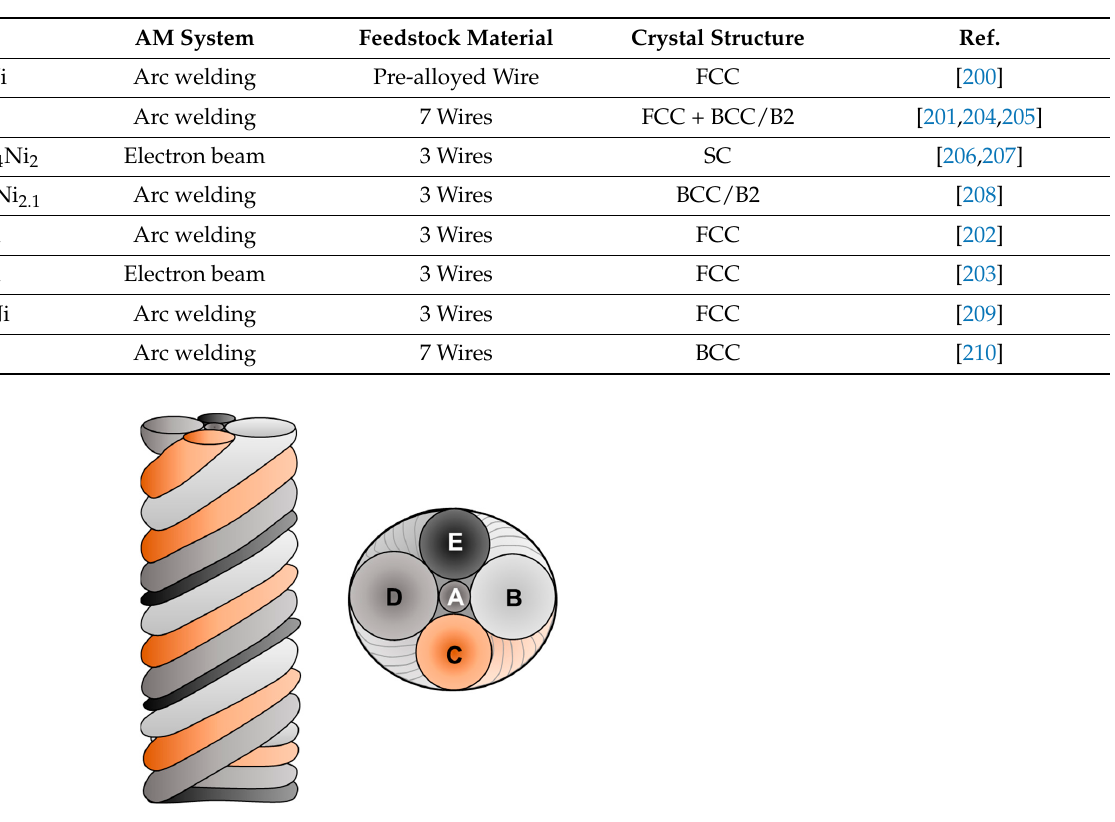
Figure 13. Schematic illustration of CCWs composed with 5 di ff erent wires (A-E) for DED process.